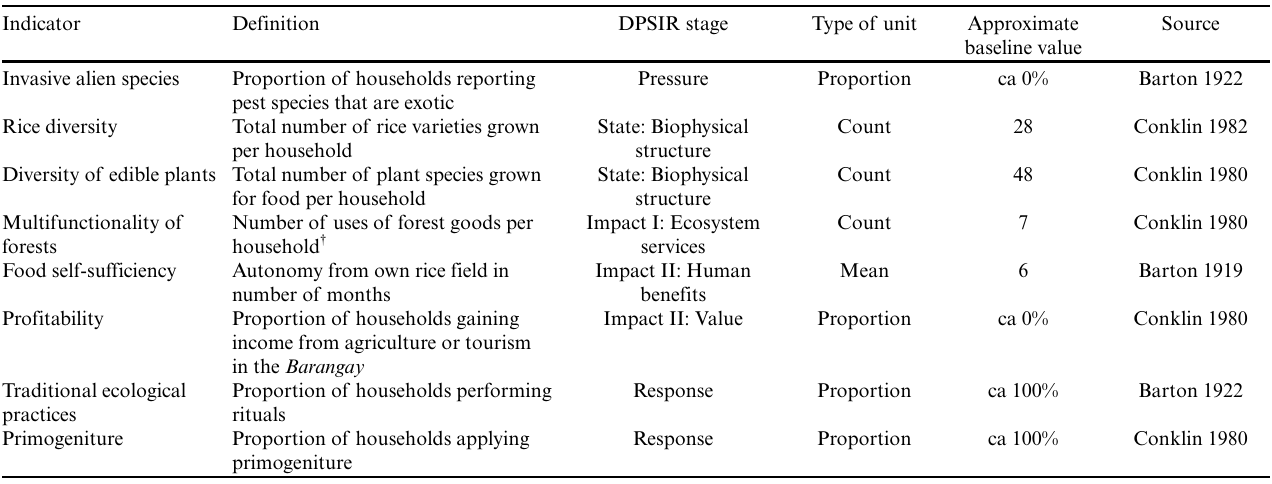
Table 1 . Baseline values of the indicators of the social-ecological system of Banaue rice terraces according to literature sources.